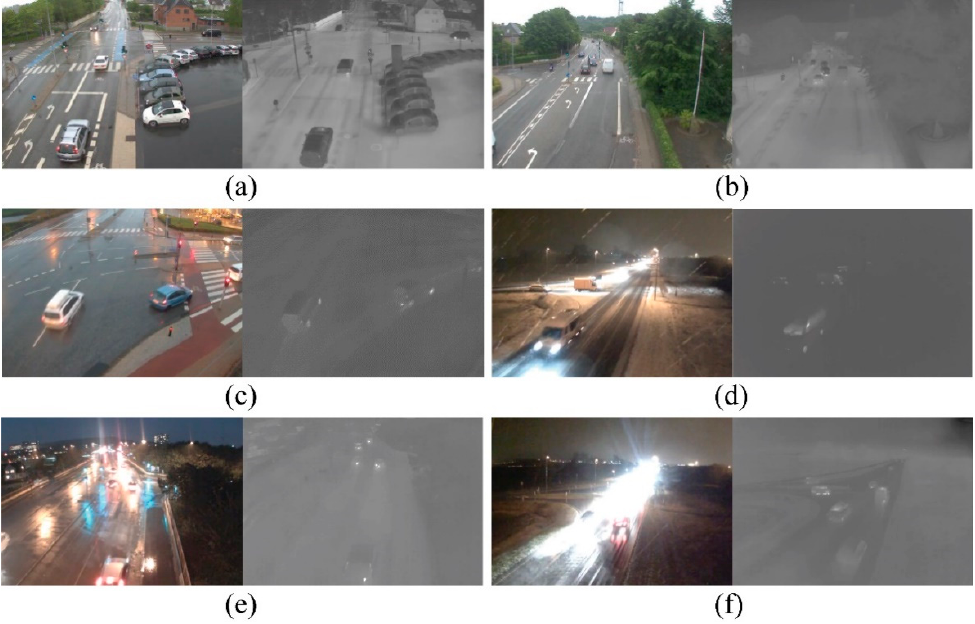
Figure 4. Some examples of images of traffic surveillance, the visible image is on the left and the infrared image is on the right. In ( a – c ), there are scenes ranging from sunny to rainy in the daytime; in ( d – f ), there are bad lighting conditions and bad visibility of the scenes; ( c ) snow; ( d ) rain and reflections; ( f ) raindrops on the camera lens.